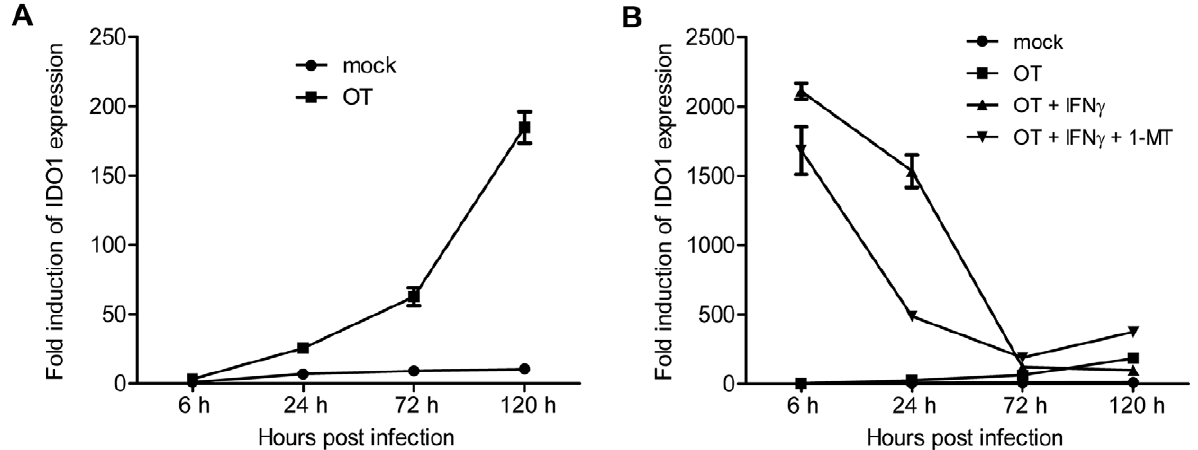
Figure 2. Kinetics of IDO1 expression in THP-1 cells. Before being infected with OT, THP-1 cells were treated with IFN- c alone, IFN- c combined with 1-MT, or neither. Mock-infected THP-1 cells were used as a control. Fold induction represents levels of IDO1 expression in each culture condition at indicated time points relative to that in mock-infected cells at 6 hours p.i.. For clearer illustration, data of OT-infected and mock-infected cultures are exclusively presented in Figure 2A, and those of all four culture conditions are shown in Figure 2B. Means 6 SEM from triplicate cultures are shown.